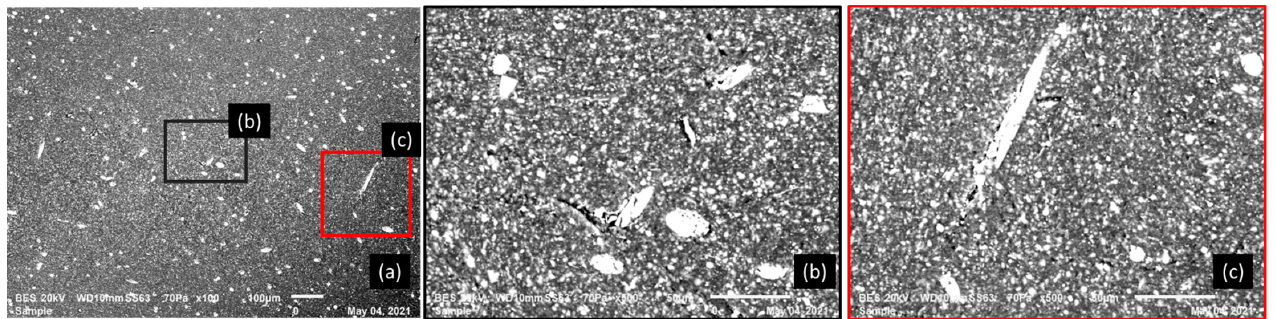
Figure 10. SEM micrographs of the transverse surface of a fractured tensile test sample with 5% GF/PBT composite, 20 kV, 10 mm working distance, 70 Pa: ( a ) BES macro-image; ( b , c ) zoom of dif- ferent regions in the zone ( a ).